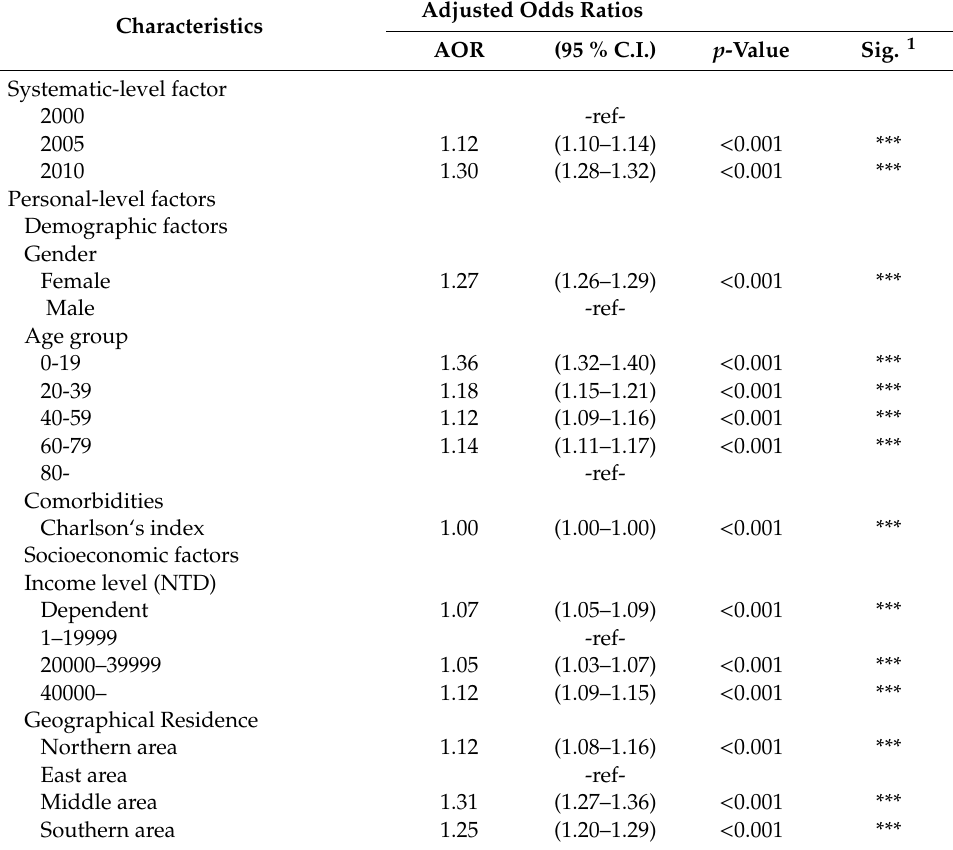
Table 2. Adjusted odds ratios (AOR) for non-emergent ED visits from three representative study cohorts (LHID2000, LHID2005, LHID2010) in Taiwan. ( n = 1,000,000 for each cohort; total ED visits, n =